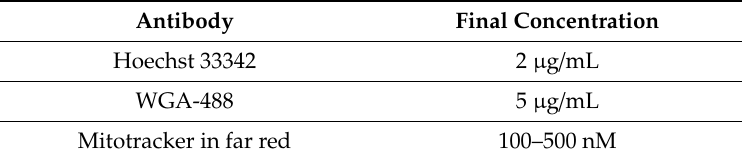
Table 1. Concentration range of Hoechst, WGA, and